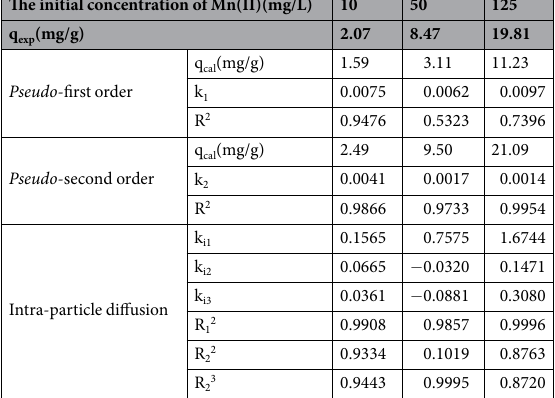
Table 2. Parameters for adsorption kinetic study.